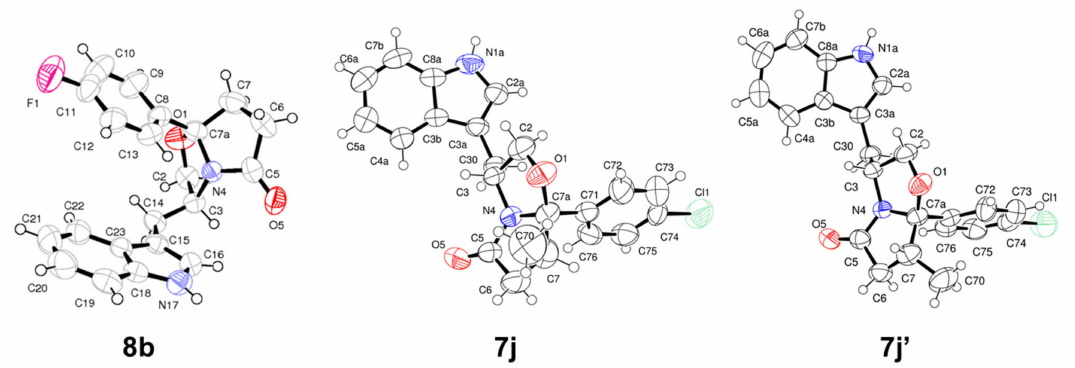
Figure 3. X-ray crystallographic structures of compounds 8b , 7j , and 7j’ (crystallographic information file (CIF) data can be found in the Supplementary Materials Tables